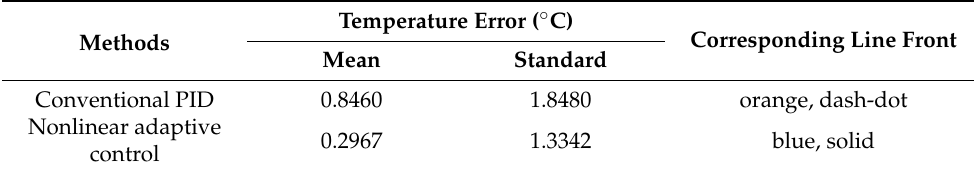
Table 1. Performance Comparison between conventional PID control and nonlinear RBF adaptive control.